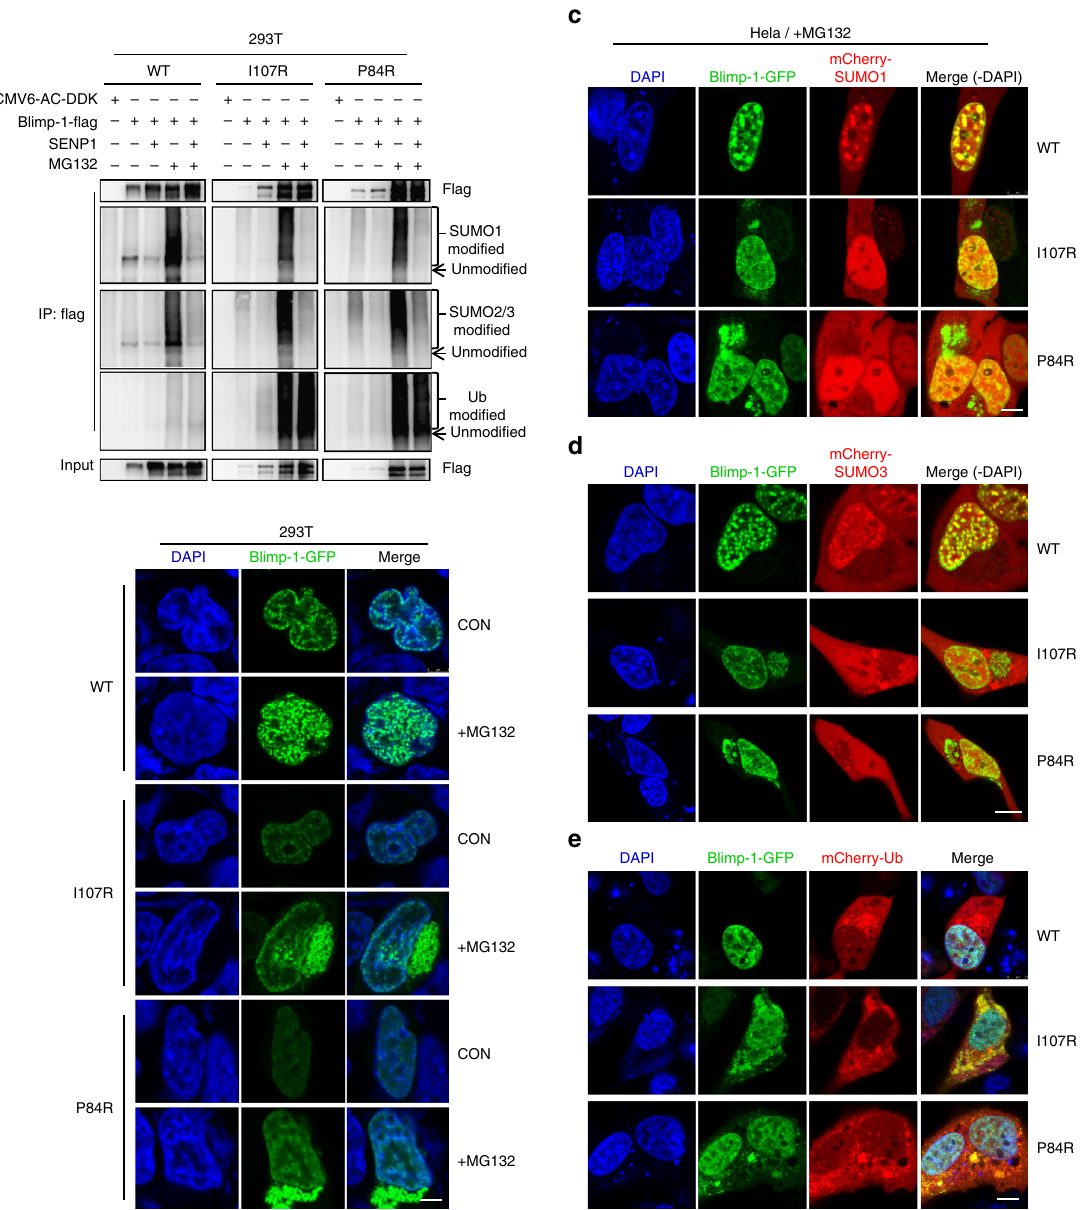
Fig. 2 The primary modi fi cation and degradation sites differ for WT and mutant Blimp-1 proteins. a Flag-tagged WT or mutant Blimp-1-expressing plasmids were co-transfected with empty or SENP1-expressing plasmid into 293T cells, and then cells were treated with or without MG132 for 24 h. The lysates were immunoprecipitated ( IP ) with anti- fl ag antibody and then immunoblotted with antibodies against Sumo1, Sumo-2/3, and Ub. b 293T cells expressing GFP-tagged WT or mutant Blimp-1 proteins were treated with MG132 or left untreated for 12 h and observed under a confocal microscope. Scale bar : 5 μ m. HeLa cells co-expressing GFP-tagged WT/mutant Blimp-1 proteins with mCherry-Sumo1 ( c ), mCherry-Sumo-3 ( d ), or mCherry-Ub ( e ) were treated with MG132 for 12 h and observed under a confocal microscope. Scale bar : 7.5 μ